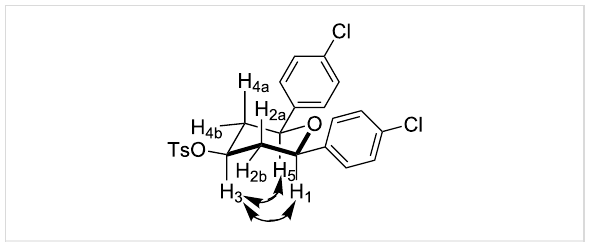
Figure 2: Schematic NOE diagram of compound 3b